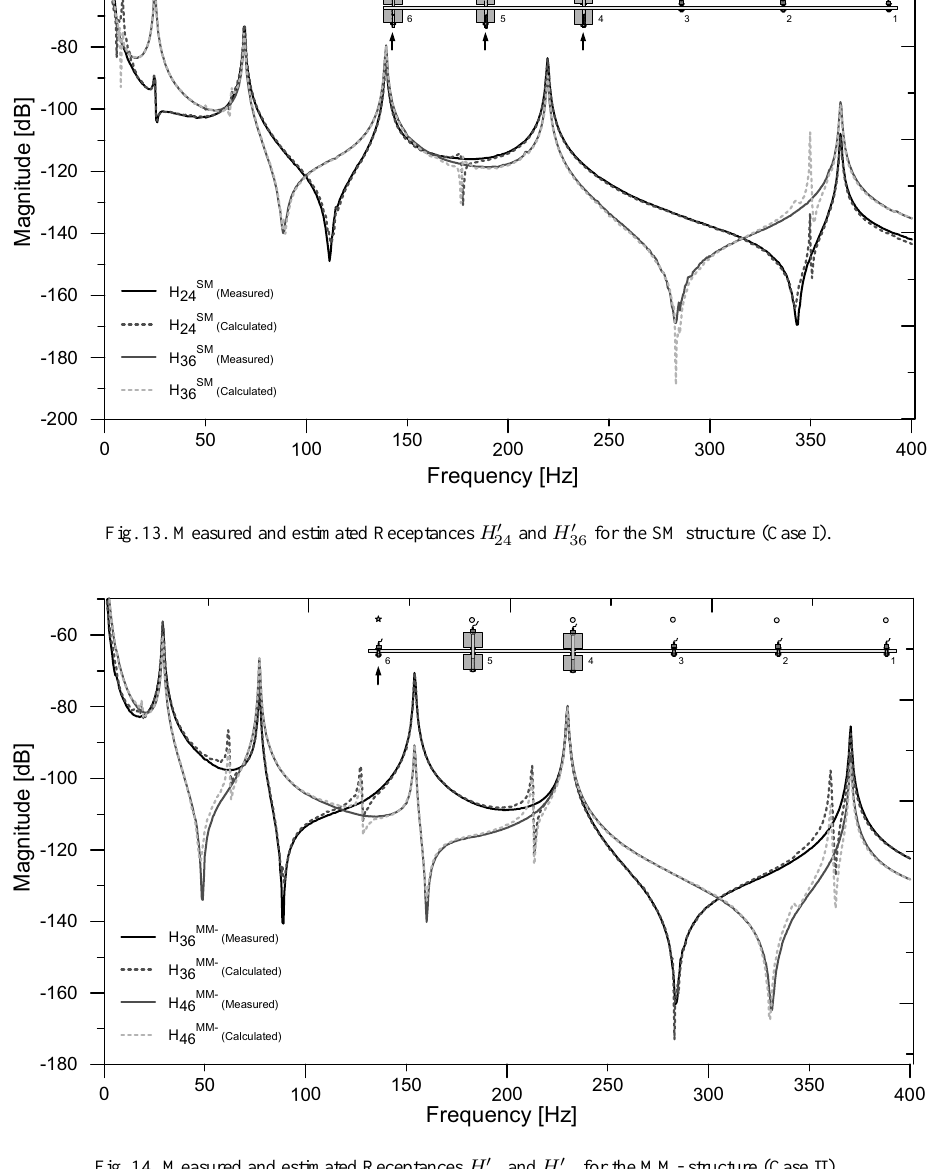
Fig. 14. Measured and estimated Receptances H (cid:2) 36 and H (cid:2) 46 for the MM- structure (Case II). higher